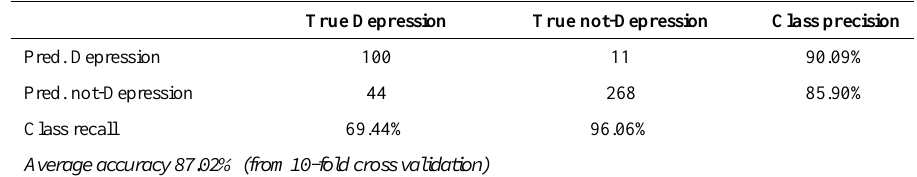
Figure 4. Suicide ROCs curves of decision tree (blue line), gradient boosting trees (green line), and random forest (red line) using all trauma items Table 7. The accuracy, precision, and recall of suicide prediction model using all trauma items with random forest classifier